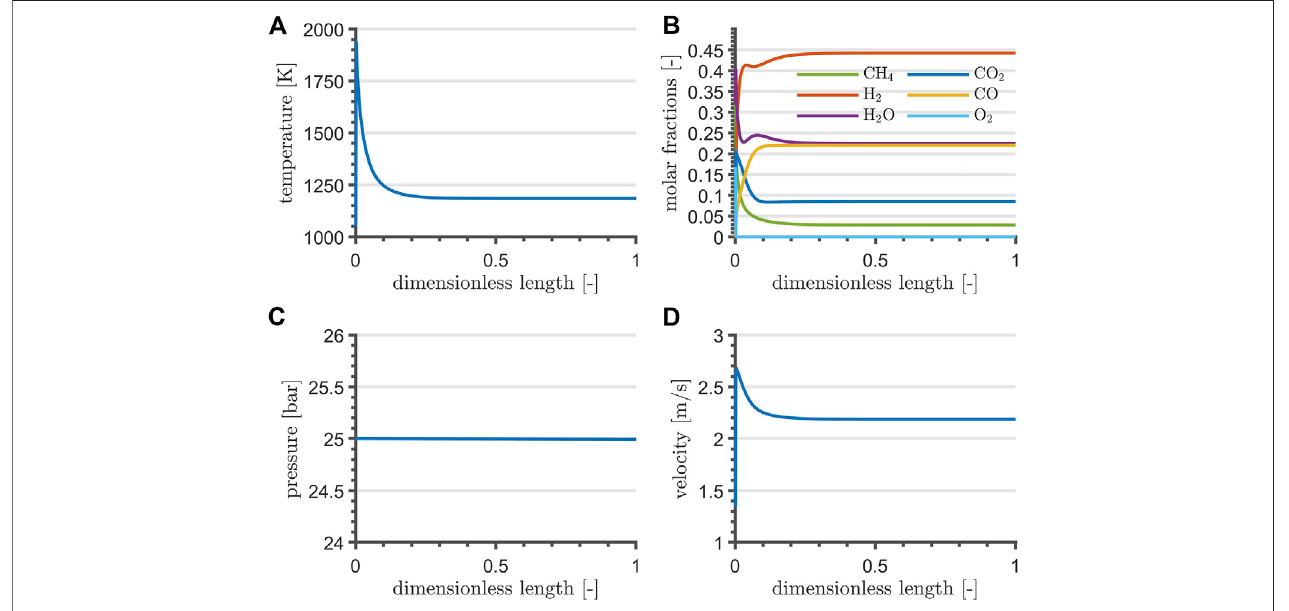
FIGURE 2 | TRI temperature (A) , composition (B) , pressure (C) , and velocity pro fi le (D) at steady-state and at nominal fl owrate.